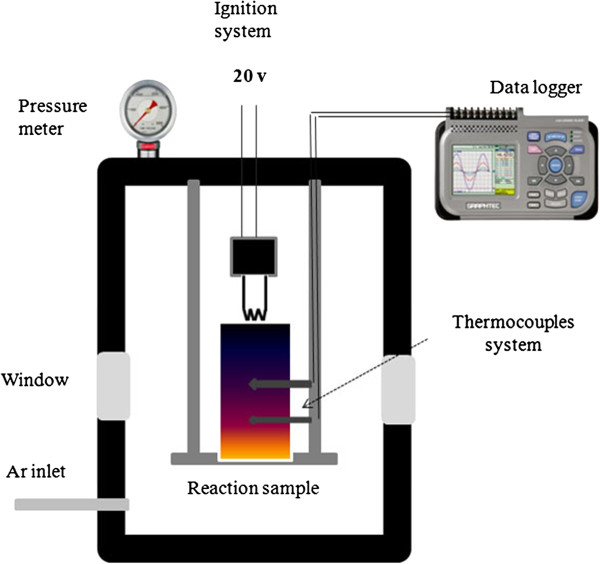
Experimental setup for the synthesis cubic TaN nanoparticles.